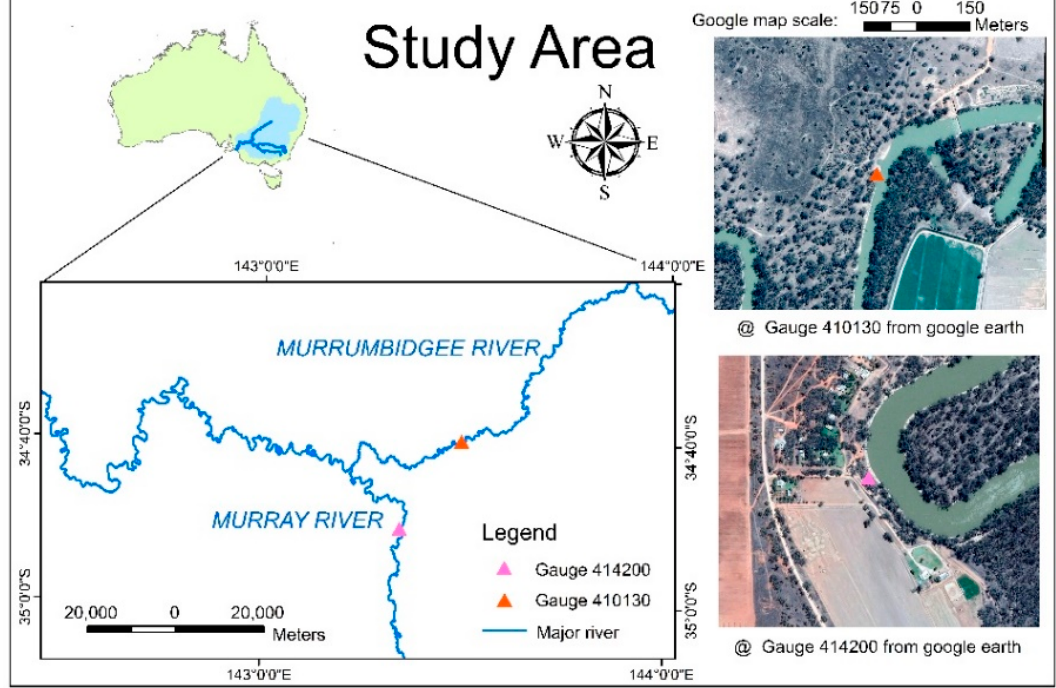
Figure 1. Location and condition of study sites. Images are obtained from Google Earth acquired on 16 November 2018. Triangles show the gauge locations.